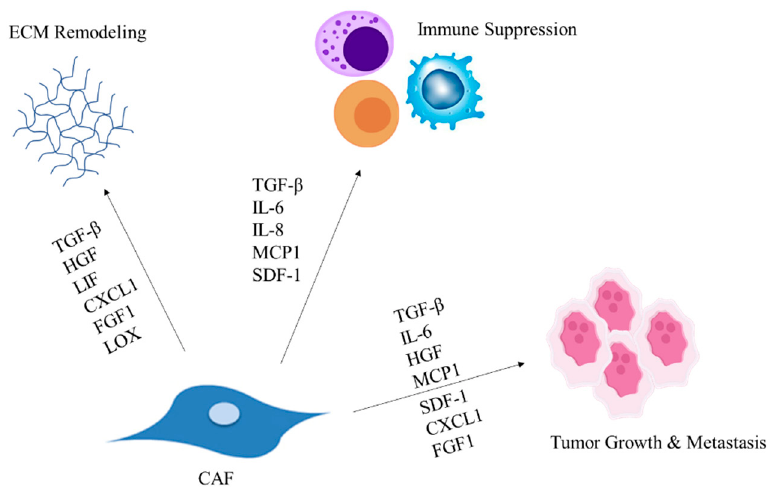
Figure 1. CAF factors influence pro-tumor processes. CAF-derived molecules TGF- β , HGF, LIF, CXCL1, and FGF1 impact ECM remodeling. Factors SDF-1, MCP1, IL-8, Il-8, and TGF- β modulate the immune system. TGF- β , IL-6, HGF, MCP1, SDF-1, CXCL1, and FGF1 impact tumor growth and me- tastasis.